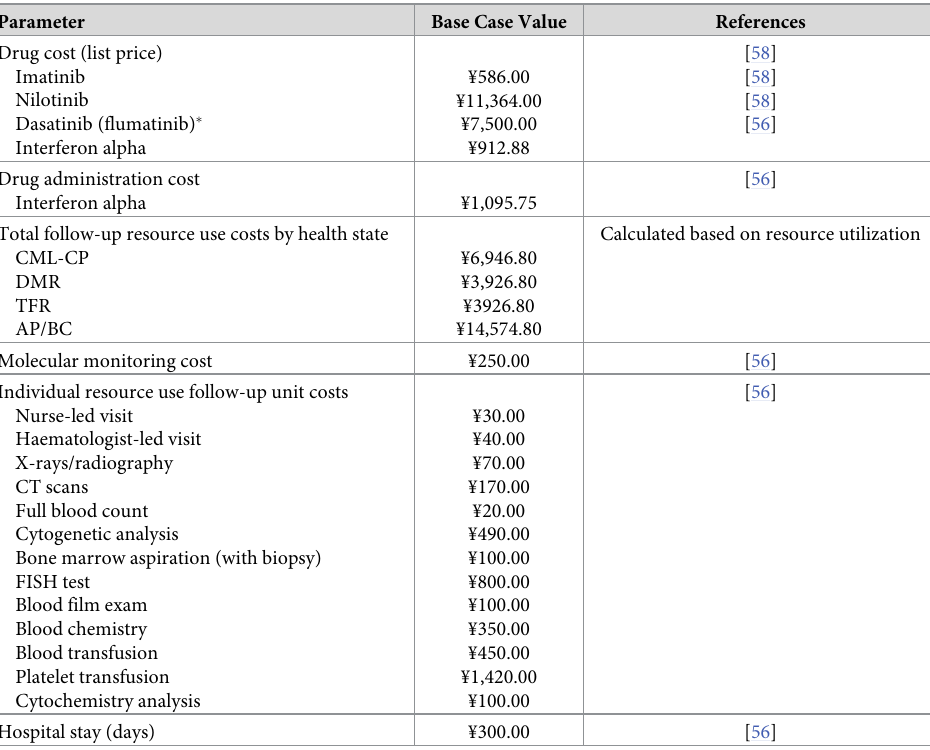
Table 2. Cost inputs for base case analysis.